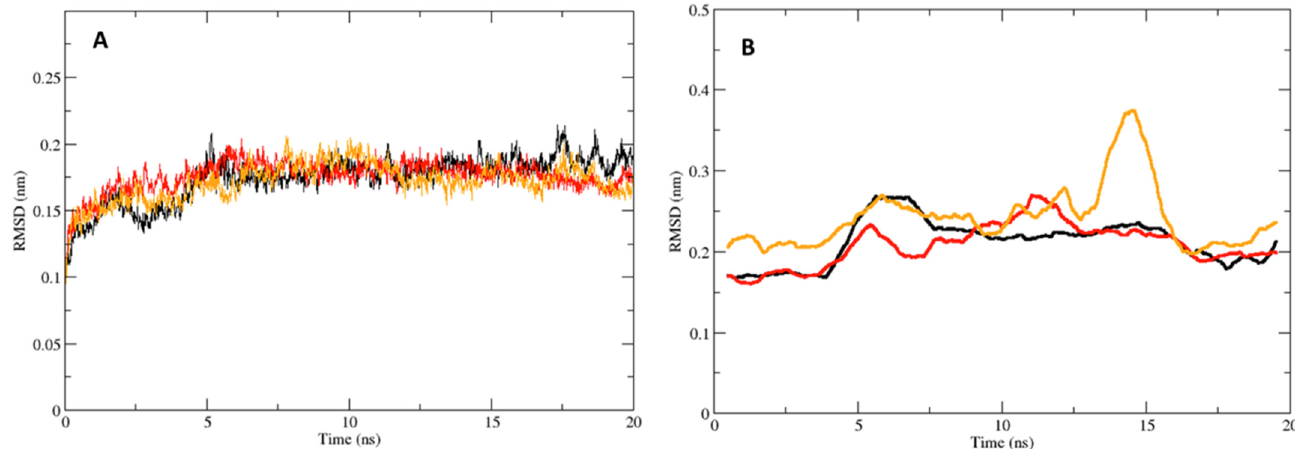
Figure 2. The RMSDs for the complexes and the compounds. ( A ) Bla2 backbone RMSD for the Bla2-Compound 4 complex in black, and Bla2-Compound 6 complex in red, and Bla2-SAHA complex in yellow. ( B ) RMSD of Compound 4 in black, Compound 6 in red, and SAHA in yellow, in relation to the protein backbone. Plotted as running averages for visual clarity.